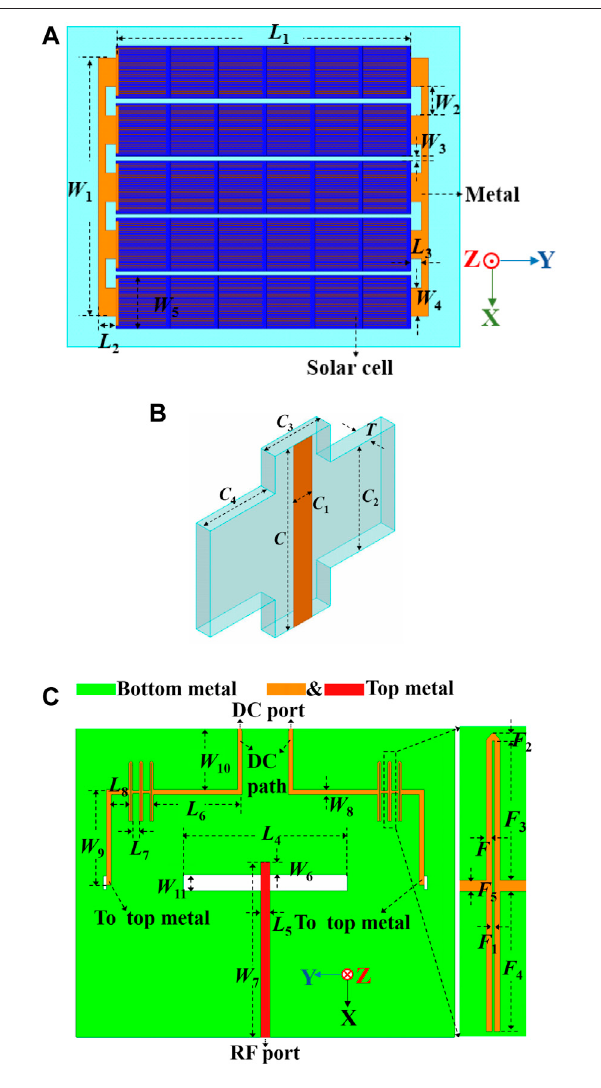
FIGURE 3 | The structure of the solar cell antenna: (A) Top view, (B) Vertical structure, (C) Bottom view.